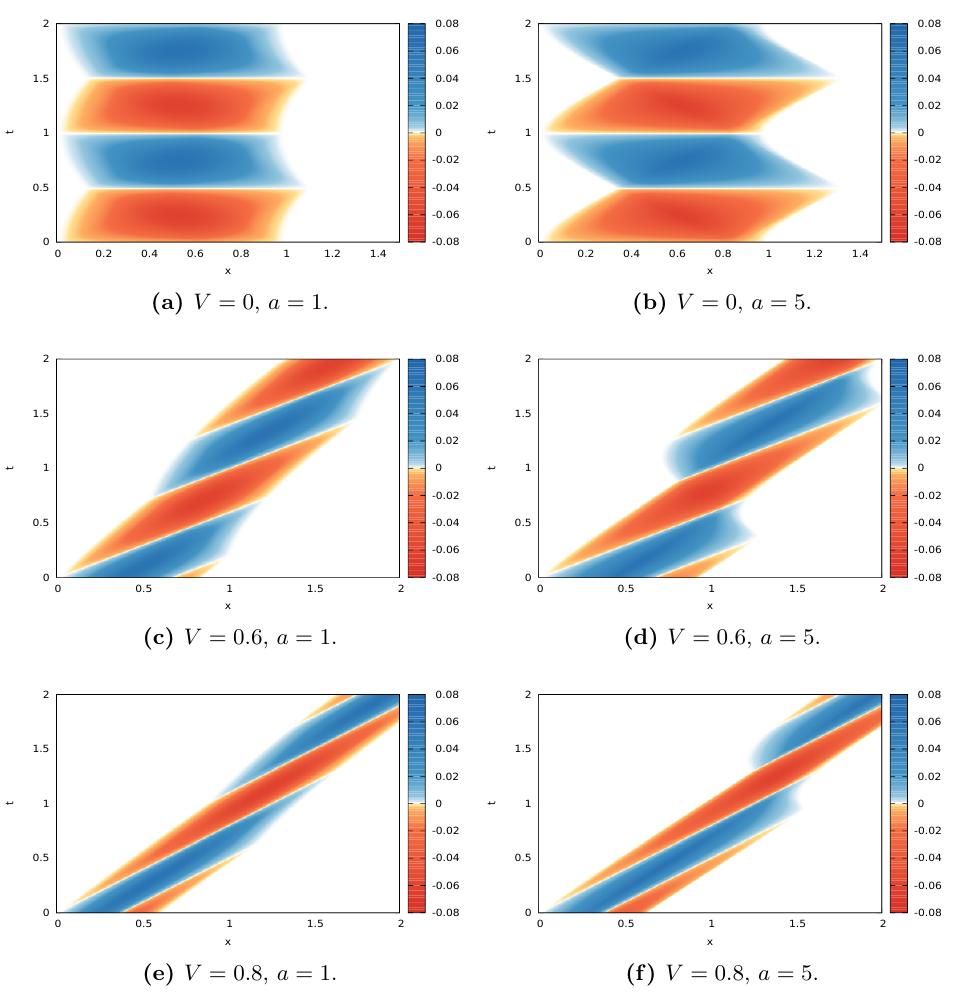
Figure 37 . Generalized exact oscillon with uniformly accelerated border for di(cid:11)erent values of the boost velocity V and acceleration a